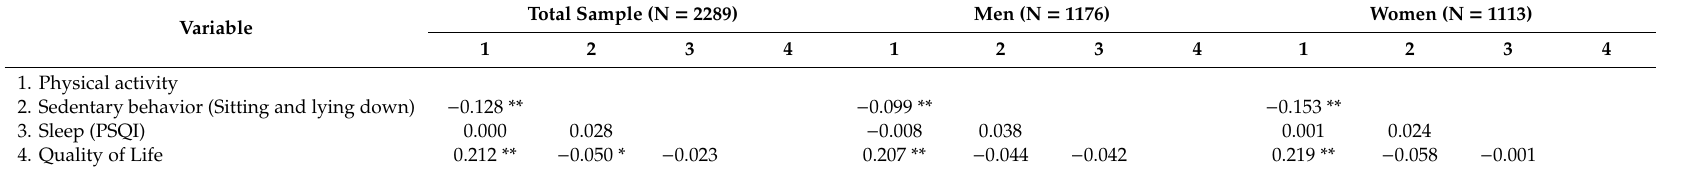
Table 3. Descriptive and correlational analyses among all outcome